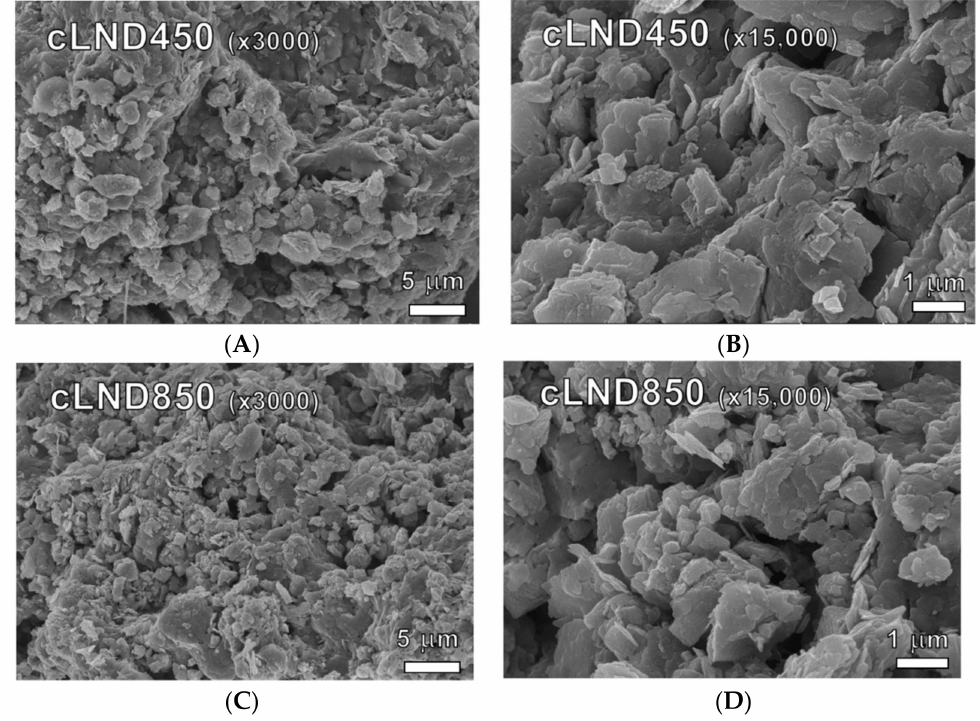
Figure 1. ( A – D ) cLND scanning electron micrograph images at 450 ◦ C and 850 ◦ C carbonization temperature (cLND450 and cLND850) at 3000 magnification and 15,000